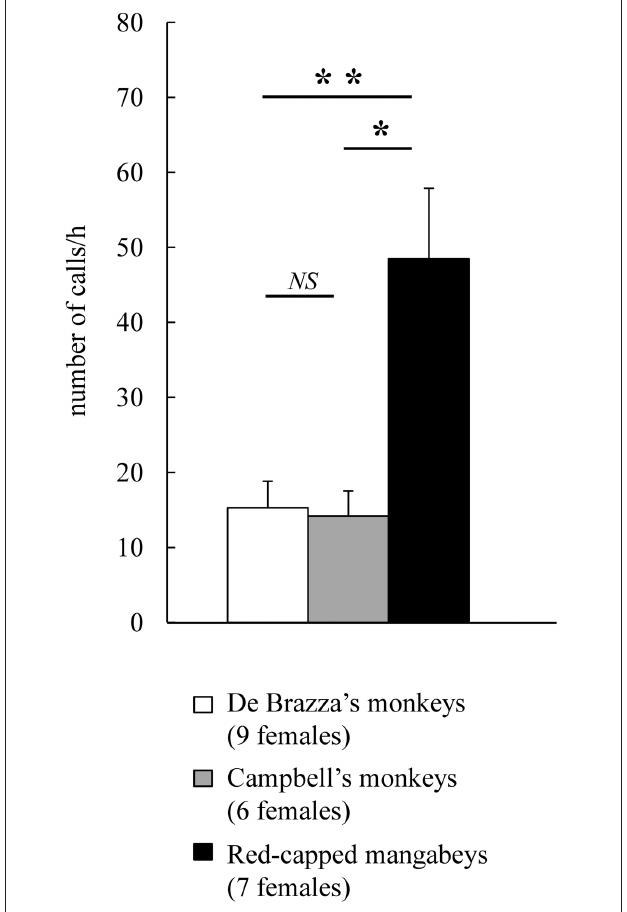
FIGURE 3 | Hourly call rates in each of three species of primate. Number of calls/h: X ± SE . Results of the post-hoc multiple comparisons following the Kruskall-Wallis test performed after removing the outlier (one De Brazza’s monkey female). The one-tailed pairwise comparisons were chosen according to the “vocal grooming” hypothesis (H1: “De Brazza’s monkeys” < “Campbell’s monkeys,” H1: “De Brazza’s monkeys” < “red-capped mangabeys,” and H1: “Campbell’s monkeys” < “red-capped mangabeys”) ( ∗∗ P < 0 . 025, ∗ P < 0 . 05, NS, not